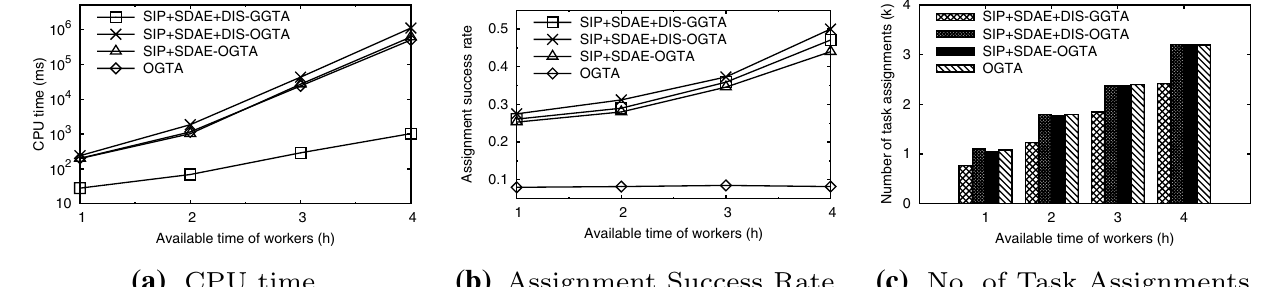
Fig. 10 Performance of group task assignment: effect of off–on